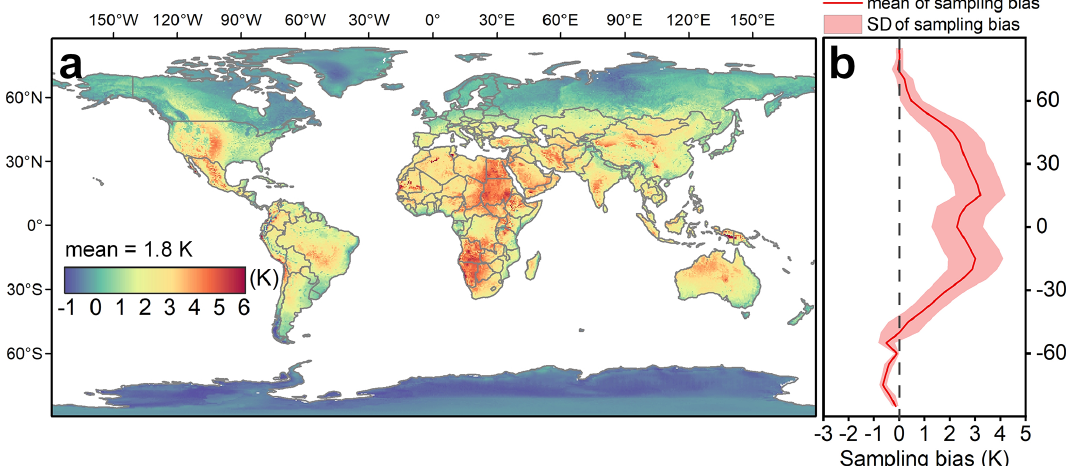
Figure 9. Average sampling bias (cid:49)T sb from 2003 to 2019. (a) Global spatial distribution of (cid:49)T sb and (b) average results for 5 ◦ longitudinal